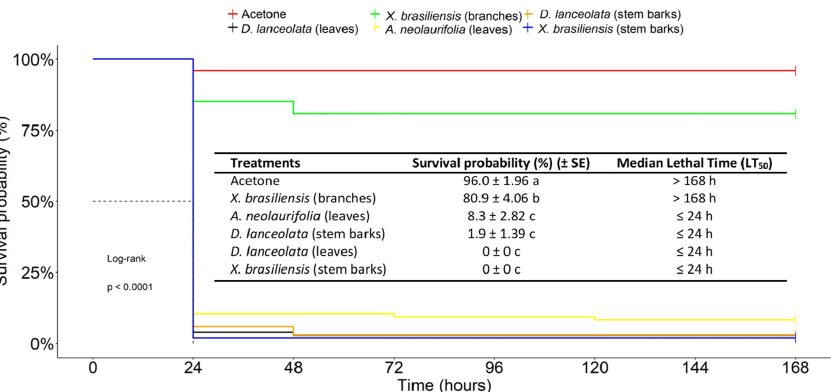
Figure 2. Survival analysis of Spodoptera frugiperda caterpillars subjected to topical application of essential oils of Annona neolaurilofia (leaves), Duguetia lanceolata (leaves and stem barks) and Xylopia brasiliensis (branches and stem barks) in the dose of 100 µ g of EO/insect. The same letters do not differ statistically by Pairwise multiple comparison